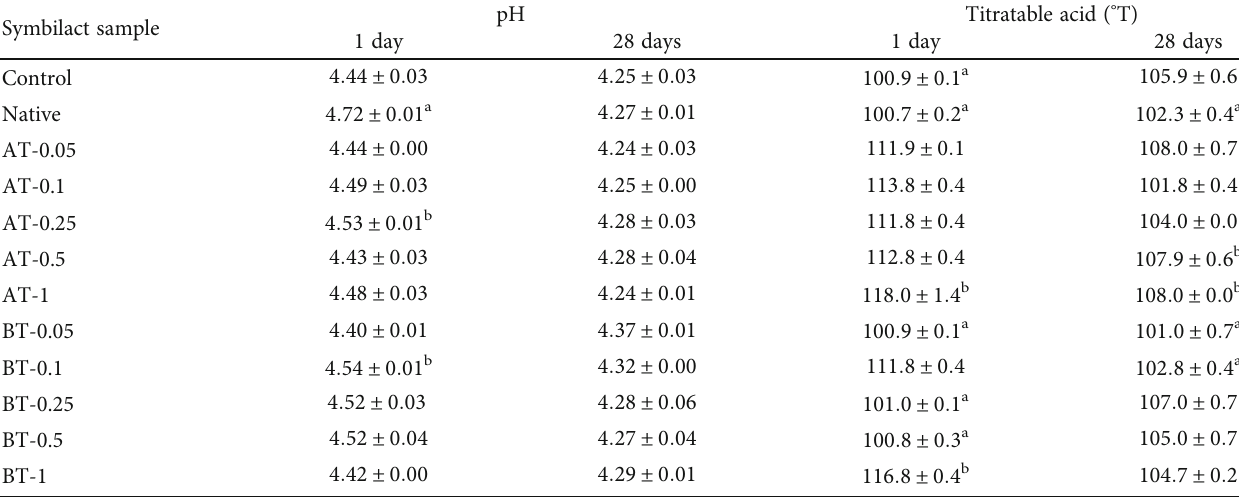
Table 3: pH measurements and titratable acidity of Symbilact sample with added di ff erent cassava starches. Symbilact